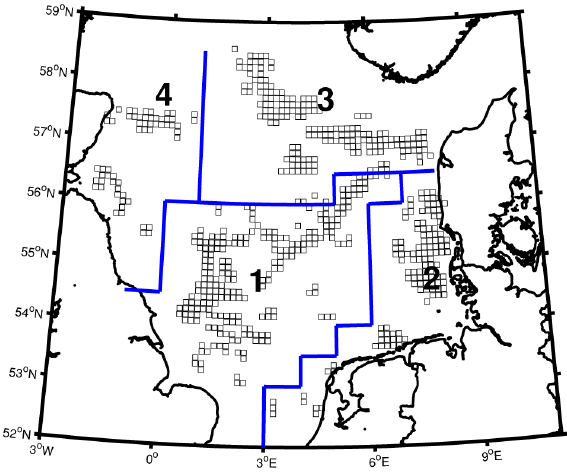
Fig. 1. Small boxes show suitable sandeel habitats resolved on a 10km scale corresponding to the POLCOMS grid. The habitat net- work is represented by 585 such cells, which is the model domain of the SPAM model. The lines indicate WGNSSK regional stock assessment areas